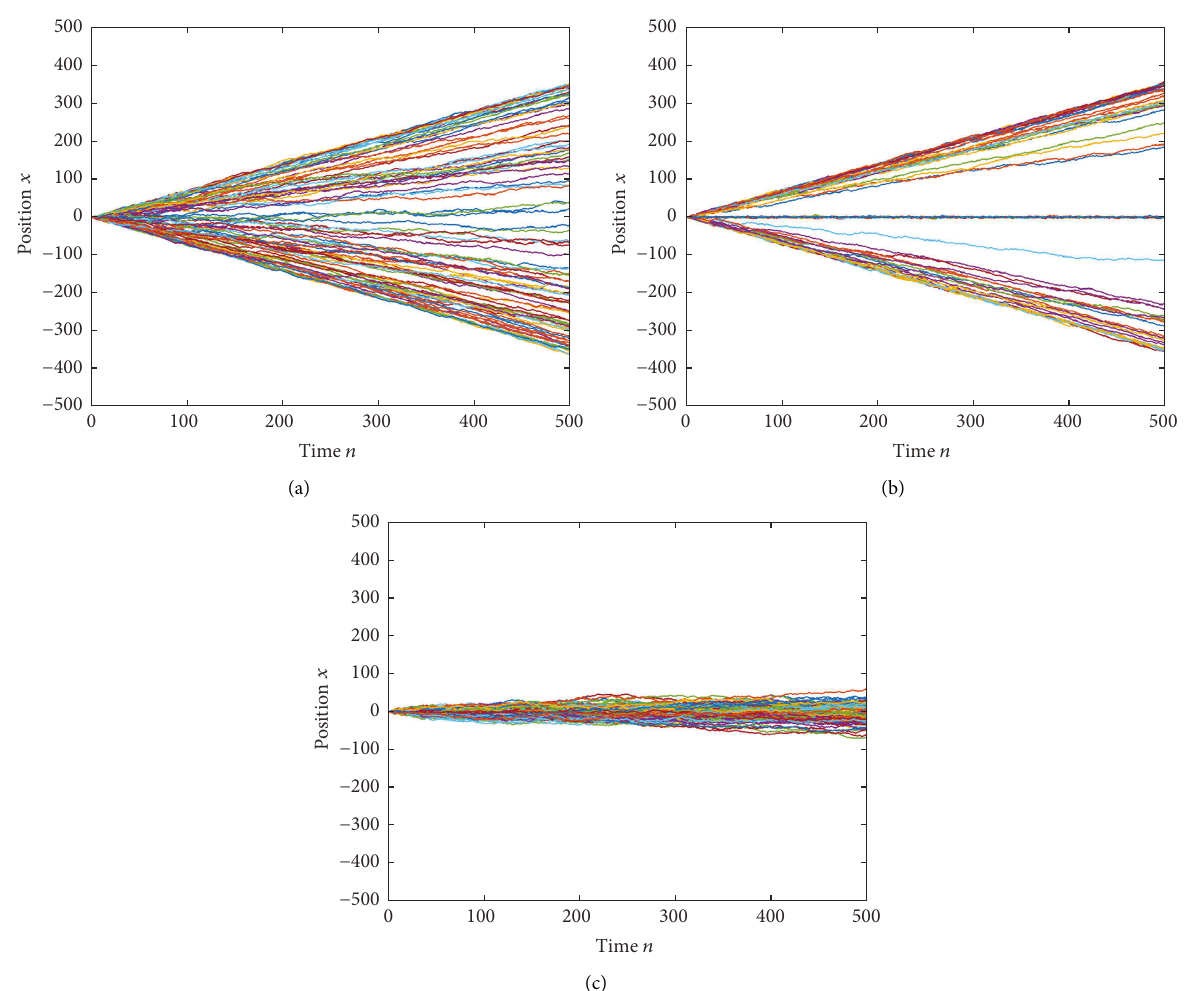
Figure 3: Paths of individual walkers in QWRWs for final time N � 500 and 100 walkers for (a) example 1 (site-homogeneous model), (b) example 2 (one-defect model), and (c) simple random walk. The linear spreading of quantum walks is visible as quasiballistic trajectories towards the edges. Paths staying around the origin in Ex. 2 (b) localization by the defect coin in the quantum